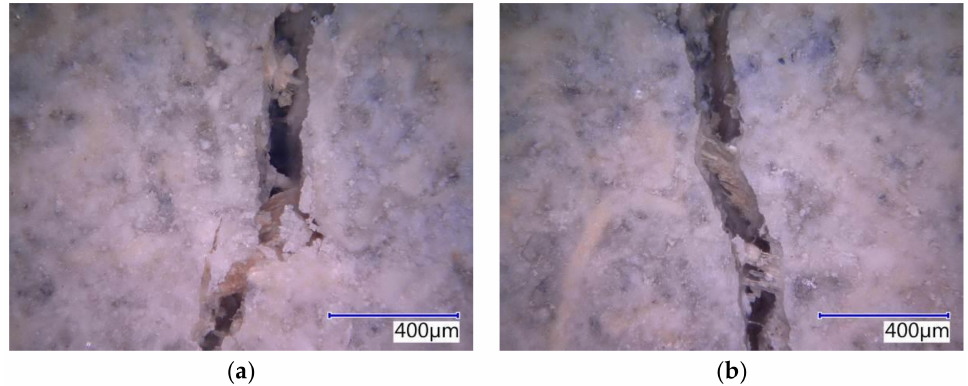
Figure 29. Detailed structure of crack PM-M25—pictures from optical microscope: ( a ) chip pulled out from the matrix; ( b ) multiple defect